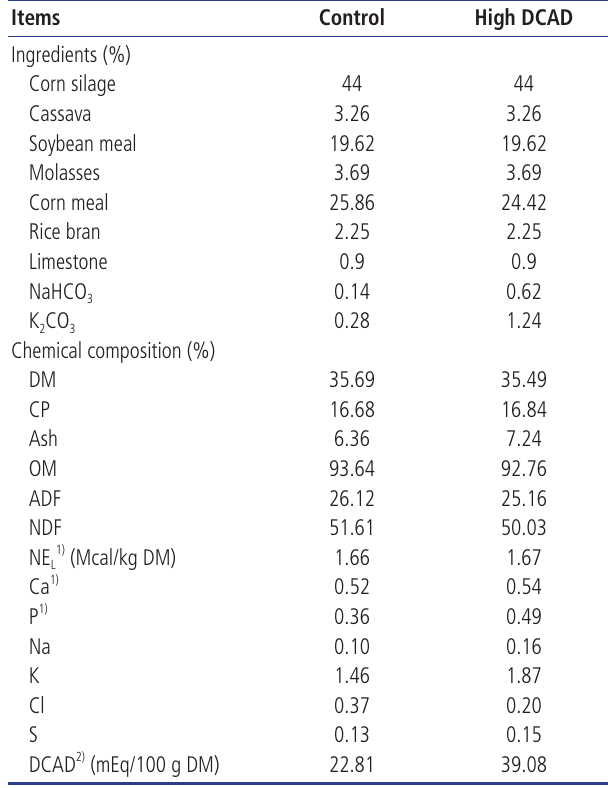
Table 1. Ingredients and chemical composition of diets Items